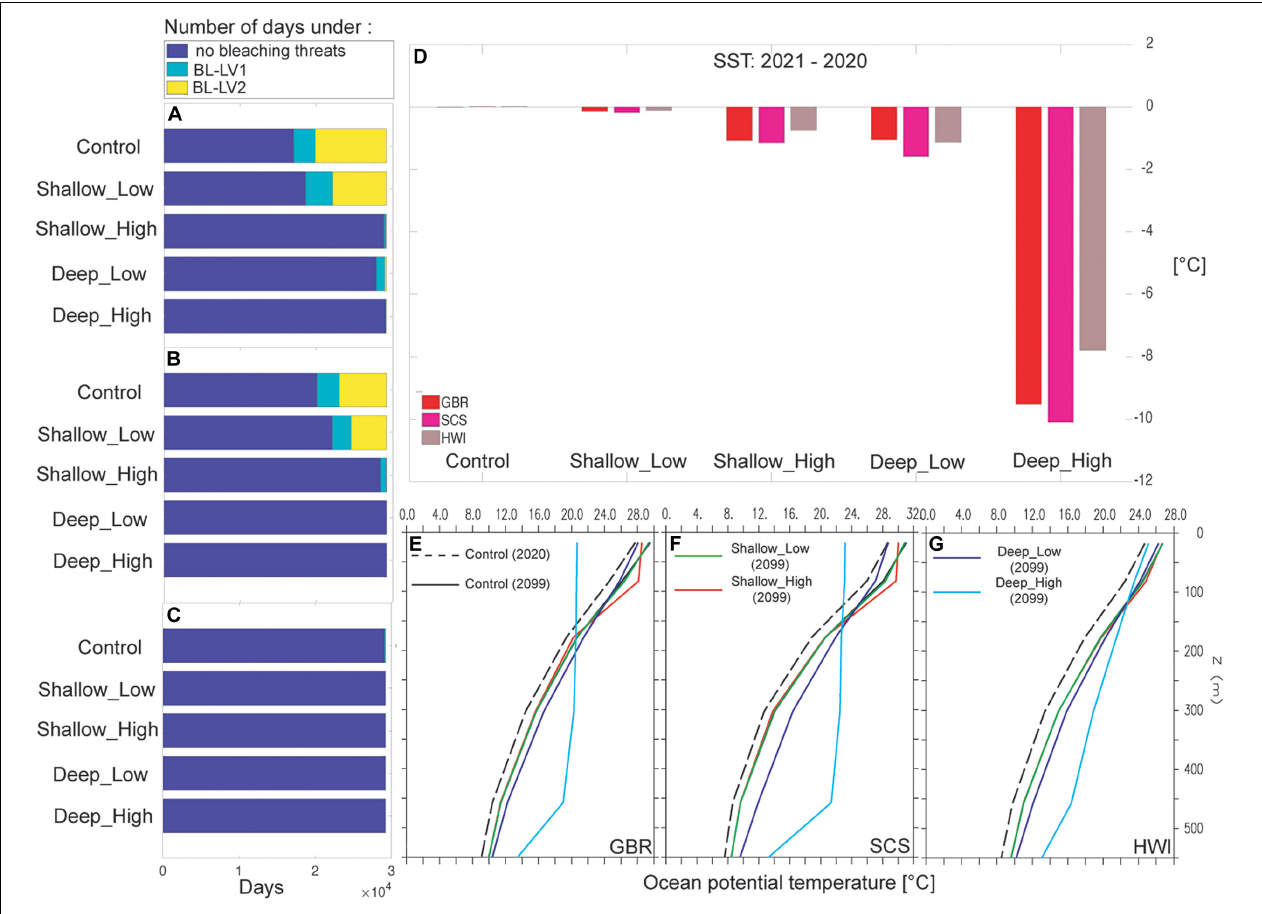
FIGURE 2 | Results of model runs for the Great Barrier Reef (GBR), South China Sea (SCS), and Hawaii (HWI) regions: The panels show, for the end of 2099, the accumulated number of days under different coral bleaching threat levels for region GBR (A) , SCS (B) , and HWI (C) ; area-averaged difference in annual mean sea surface temperature (SST) between 2021 and 2020 (D) ; and area-averaged annual mean sea potential temperature for depths to 550 m (E–G)